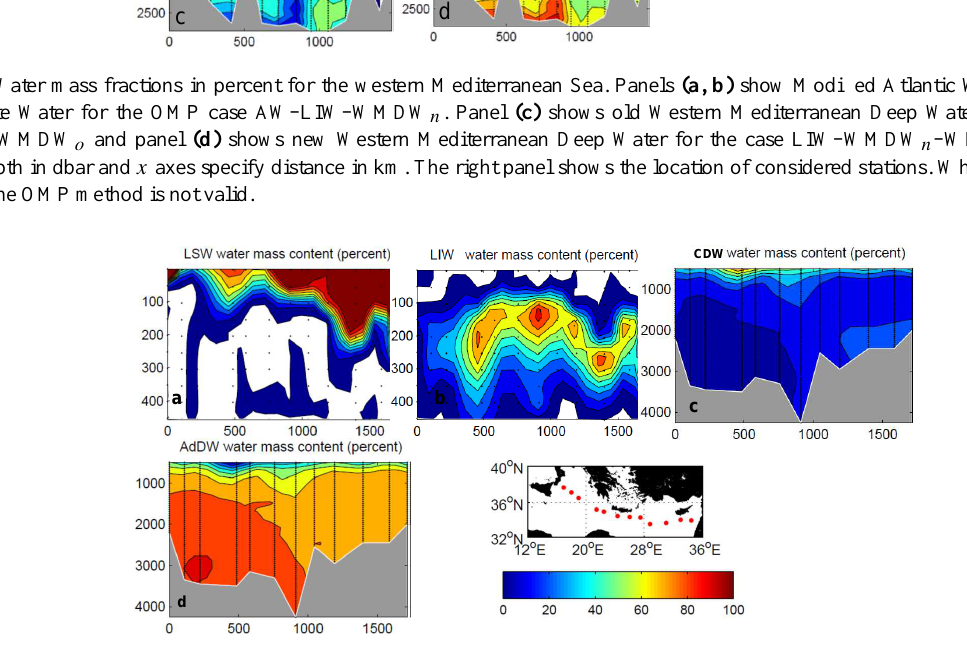
Figure 8. Water mass fractions in percent for the eastern Mediterranean Sea. (a) Levantine Surface Water from surface to 500m. (b) Levantine Intermediate Water from surface to 500m. Panels (a, b) result from the OMP run which combines AW, LSW and LIW in the upper 500m. (c) Cretan Deep Water from 500m to bottom. (d) Adriatic Deep Water from 500m to bottom. Panels (c, d) result from an OMP combination of AW, AdDW and CDW from 500m down to the bottom. Lower right panel: location of section and colour scale for percentage. Left axis of panels: depth in dbar; lower axis: distance in km. White patches are areas for which the OMP method is not